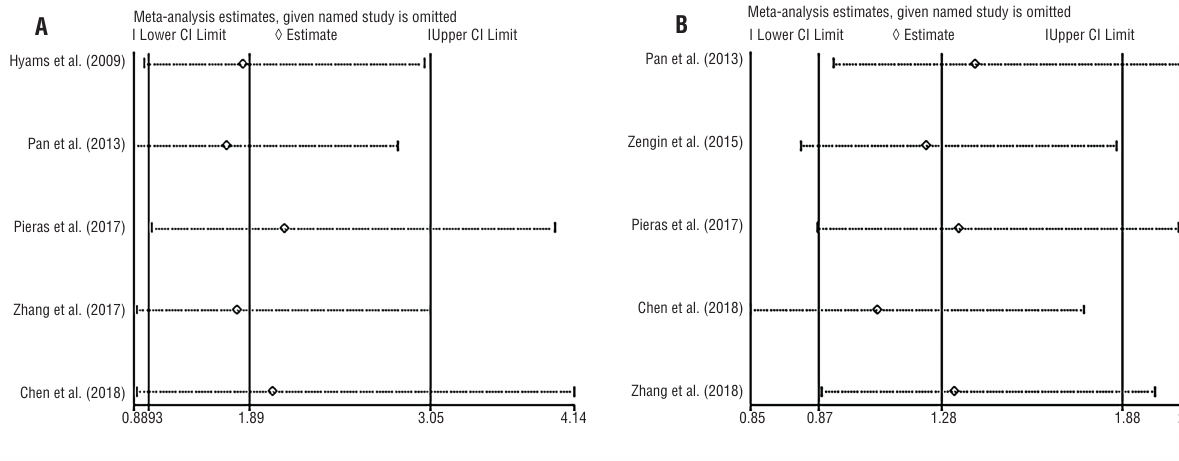
Figure 6 - Sensitivity analysis of comparison regarding (A) final SFR and (B) overall